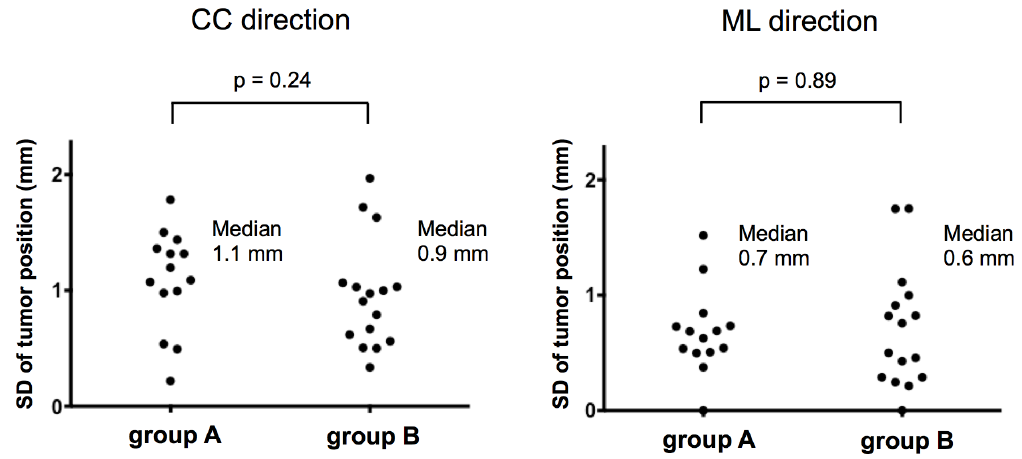
Figure 4. Standard deviation (SD) of the tumor position on electronic portal imaging device (EPID) images. Each point represents a single patient’s SD of the tumor position during all treatment sessions. CC = craniocaudal; ML =